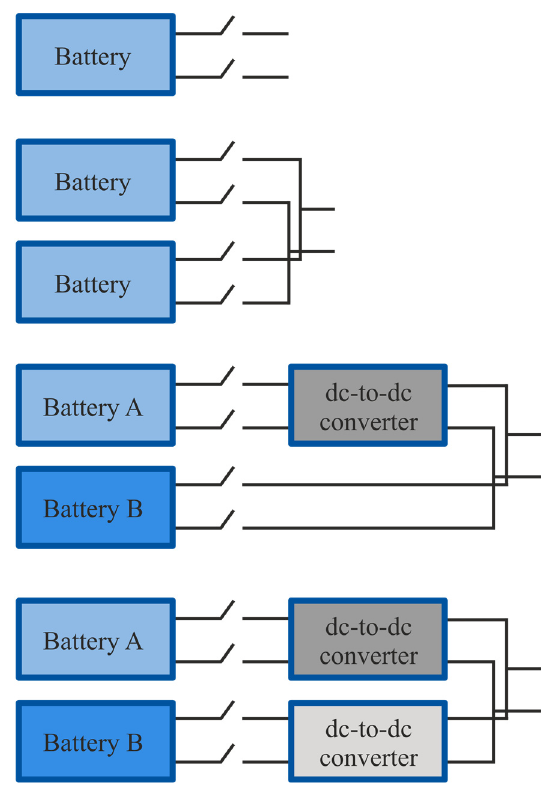
Figure 7. Topologies for batteries in automotive